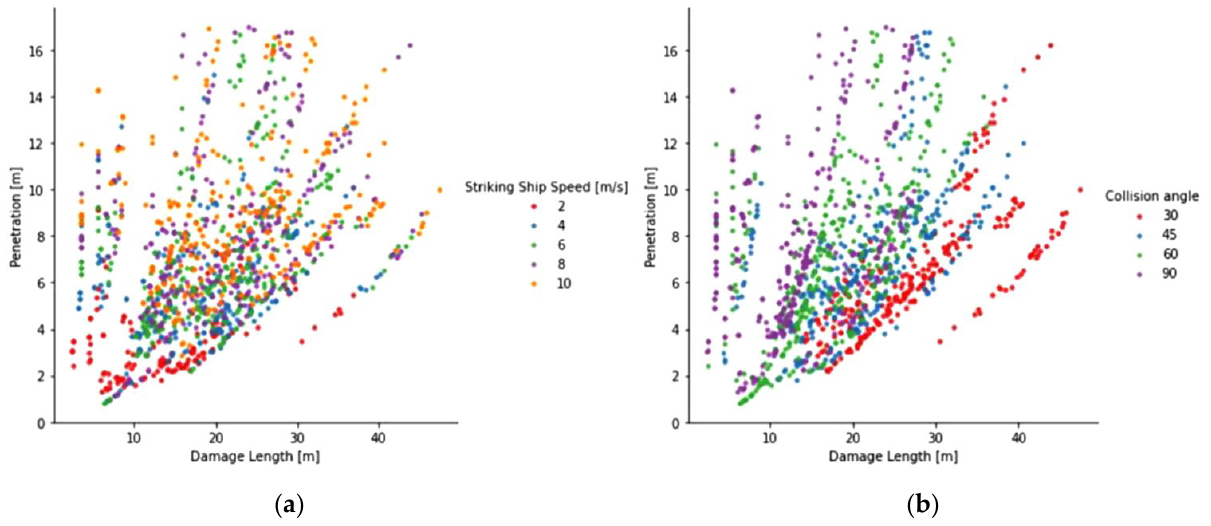
Figure 24. Penetration versus damage length for simulated damages: ( a ) data clustered by collision angle; ( b ) data clustered by striking ship initial velocity .